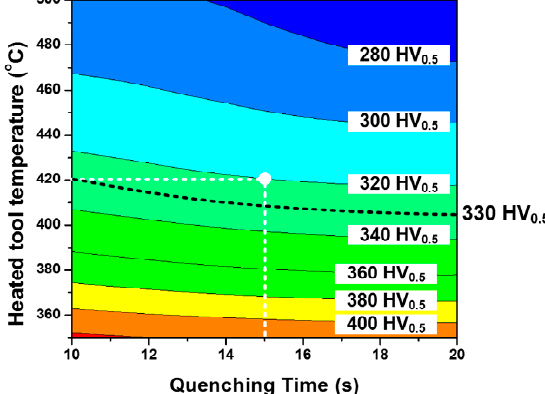
Figure 8. Process window to predict hardness of low strength region for various tool temperature and quenching time. Table 6. Comparison of predicted hardness between FE simulation and process window.